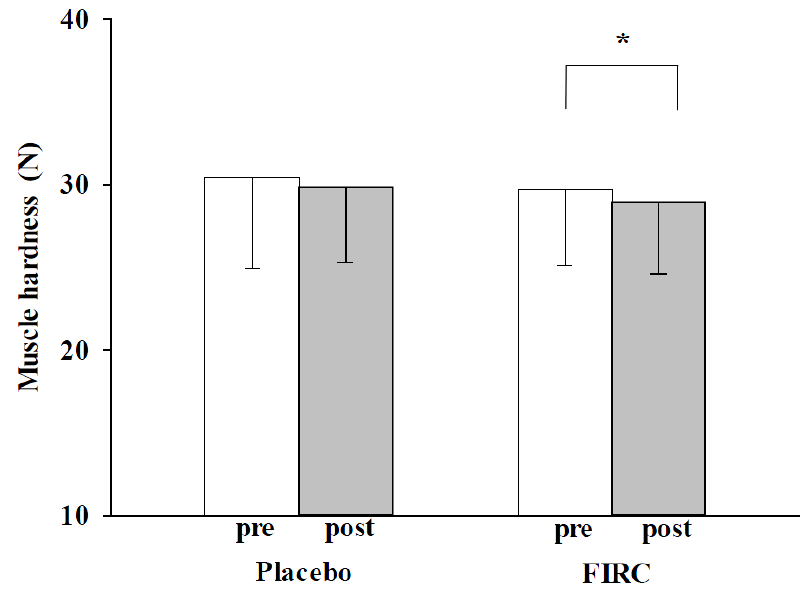
Figure 1. Changes in neck muscle hardness of placebo and FIRC groups before and after intervention. Asterisk indicates a significant difference.